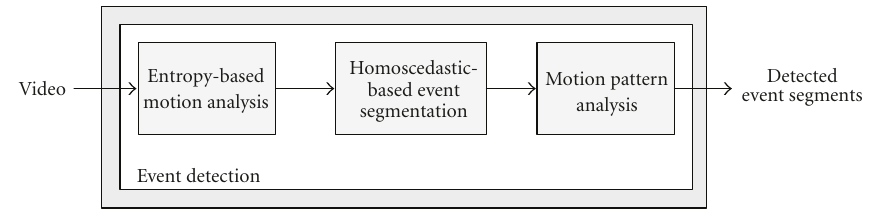
Figure 5: Block diagram of the proposed architecture.